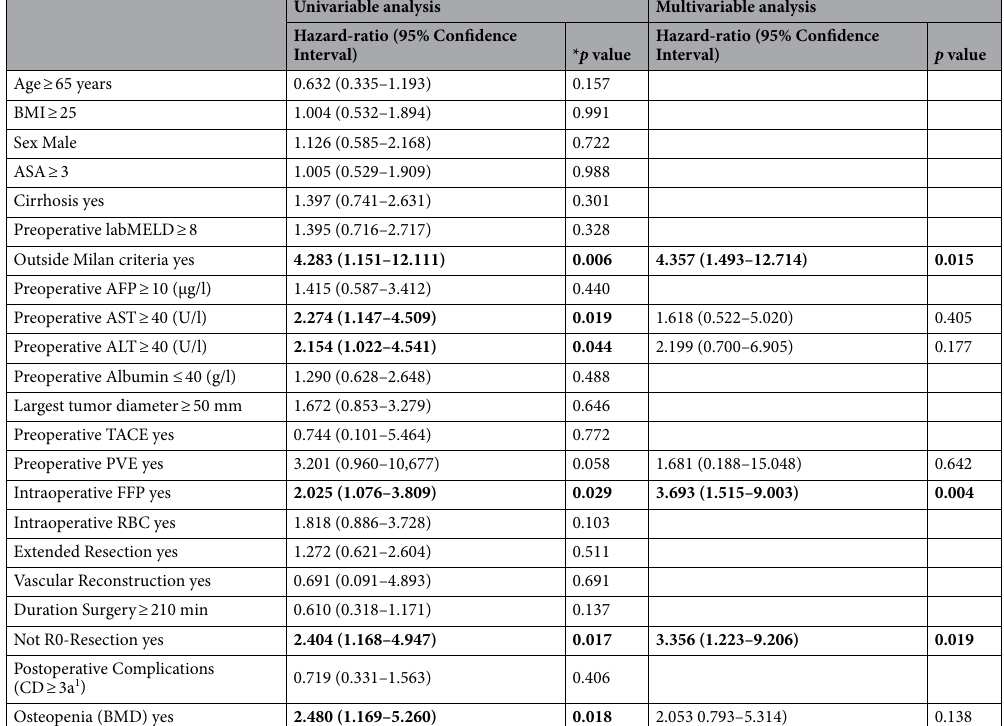
Table 5. Uni- and multivariable Cox regression analysis for disease-free survival. Results of the Cox regression analysis were given as Hazard-ratios with 95% confidence interval. 1 Refers to Clavien et al. 26 . BMI Body mass index; ASA American Society of Anesthesiologists; MELD model for end-stage liver disease; AFP alphafetoprotein; AST Aspartate aminotransferase; ALT Alanine aminotransferase; TACE Transarterial chemoembolization; PVE Portal venous embolization; FFP Fresh frozen plasma; RBC Red blood cell unit; CD Clavien-Dindo classification; BMD Bone mineral density. Significant values are in